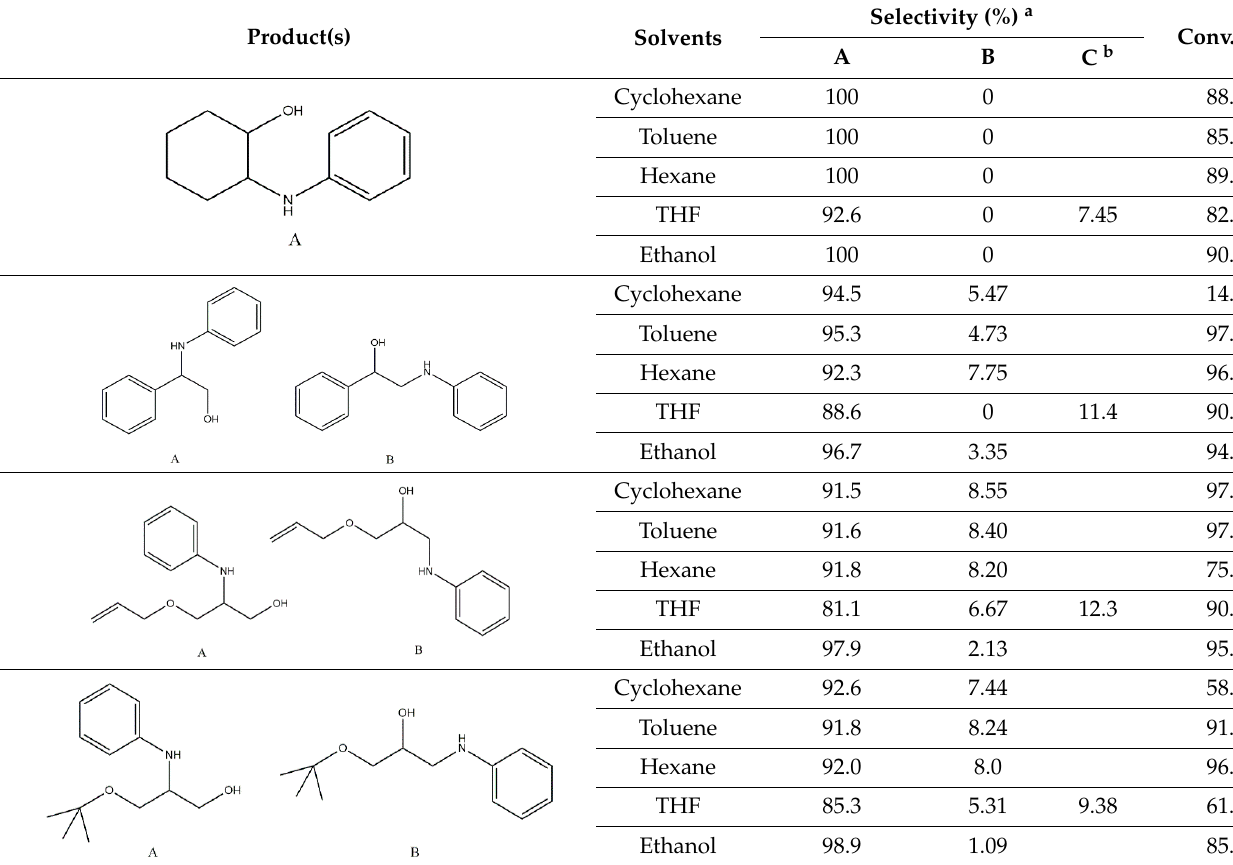
Table 2. Solvent and substrate variation.